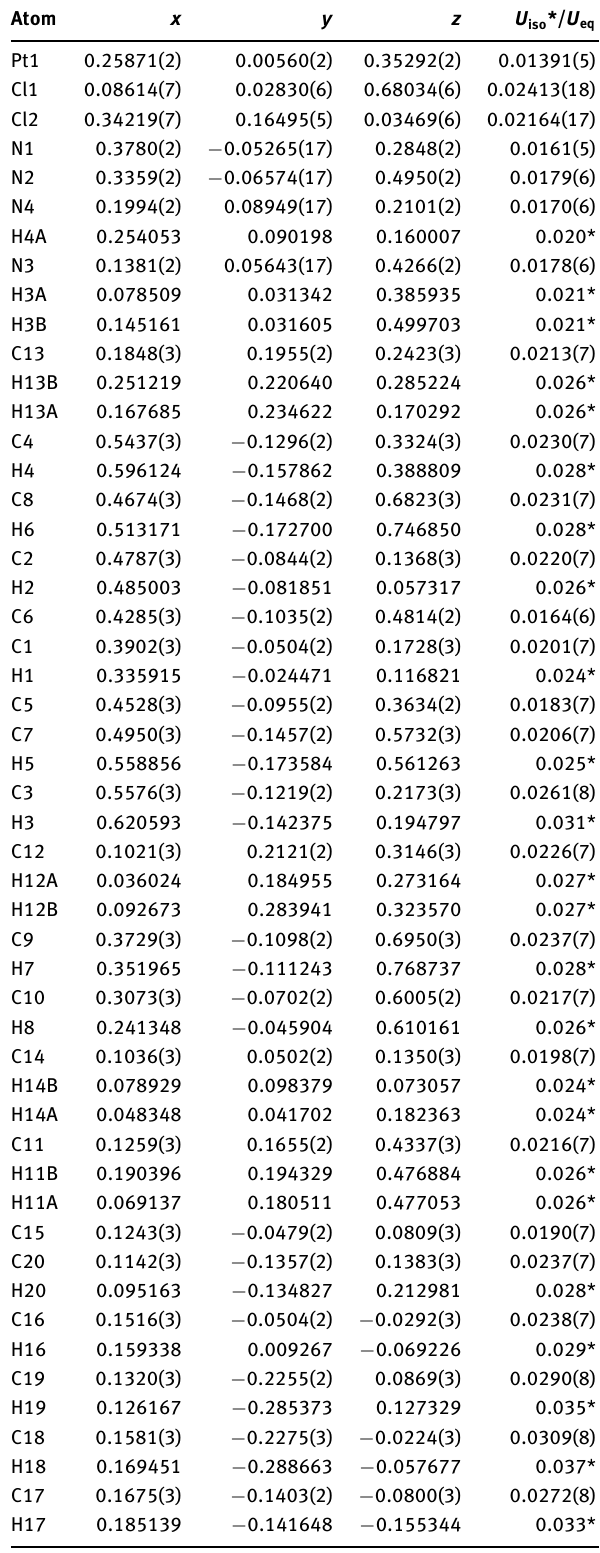
Table 2: Fractional atomic coordinates and isotropic or equivalent isotropic displacement parameters (Å 2